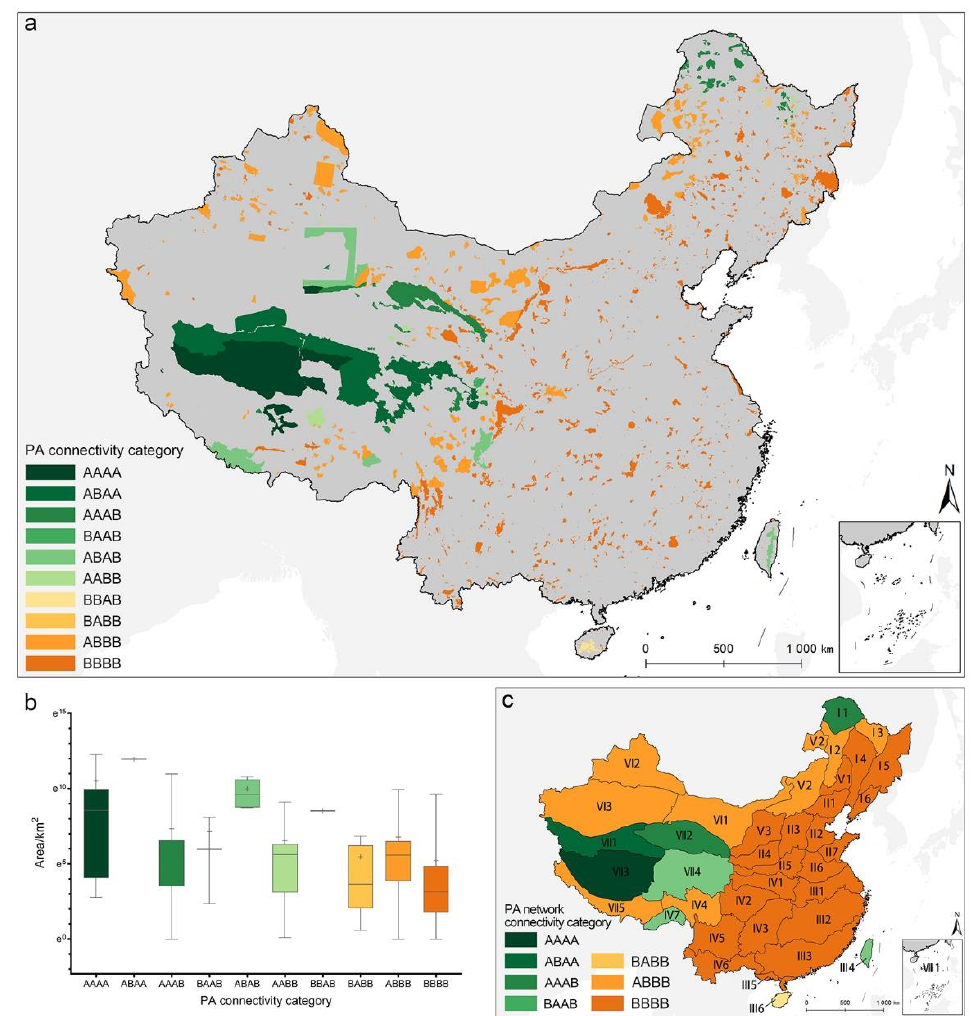
Figure 3. ( a ) Connectivity strategy classification of PA patches in China. ( b ) Distribution of area of PA patches under different categories of connectivity strategies in China. ( c ) Connectivity strategy classification of ecological zones’ PA network in China.